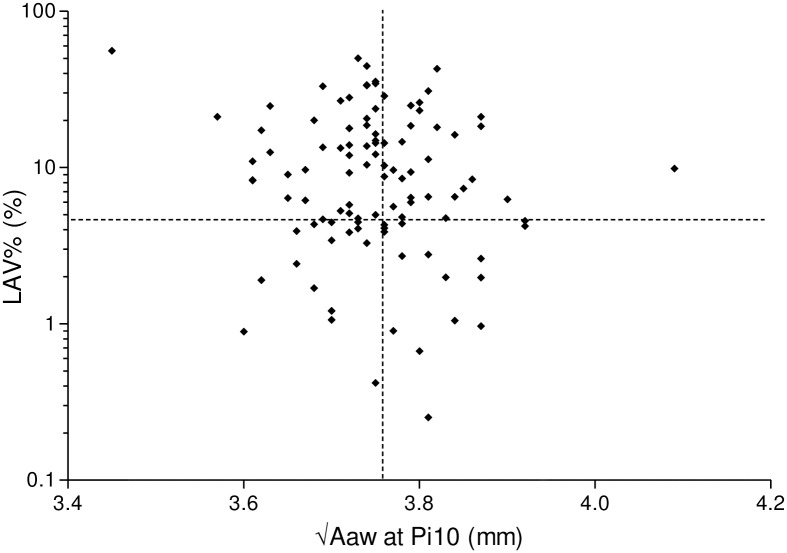
Relationship between √Aaw at Pi10 and the LAV% in 105 COPD patients.The horizontal line shows the third quartile of the LAV% of the non-COPD smokers. The vertical line shows the third quartile of the √Aaw at Pi10 of the non-COPD smokers. Using these cut-off values, the COPD patients can be divided into 4 phenotypes; normal by CT (NCT; low LAV% and low √Aaw at Pi10), airway-dominant (AD; low LAV% and high √Aaw at Pi10), emphysema-dominant (ED; high LAV% and low √Aaw at Pi10) and mixed (Mixed; high LAV% and high √Aaw at Pi10) phenotypes.